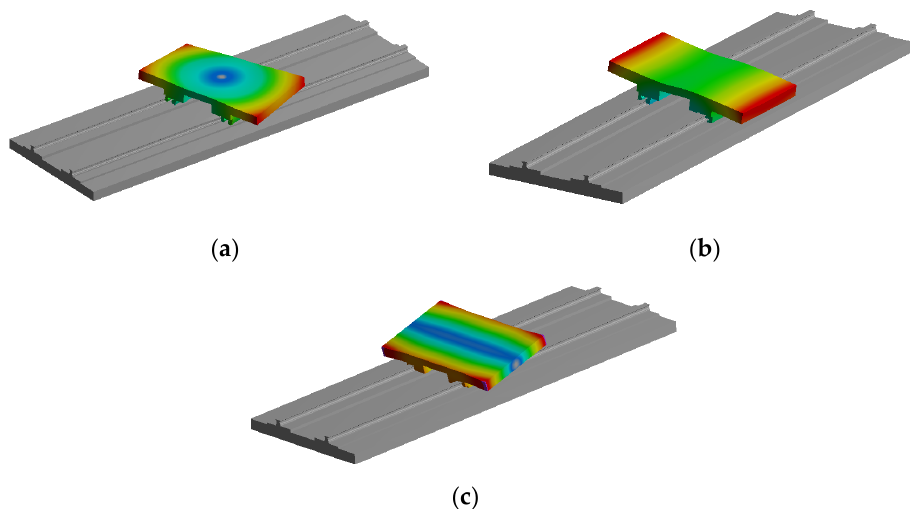
Figure 7. Fundamental vibration modal shapes of stage: ( a ) yawing mode; ( b ) rolling mode; and ( c ) pitching mode.